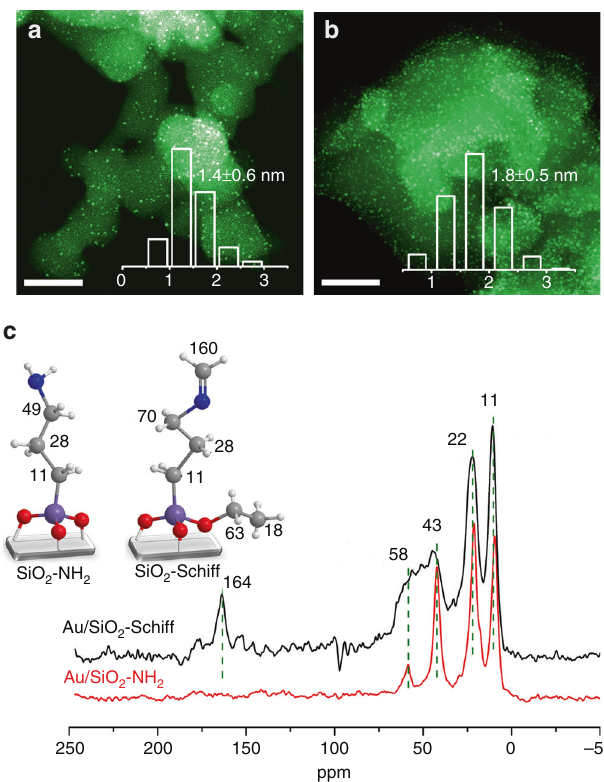
Fig. 1 Structural characterization of the two different functionalized gold catalysts. HAADF-STEM images of the prepared Au/SiO 2 -Schiff a and Au/SiO 2 -NH 2 b catalysts. Scale bar, 50 nm. 13 C CP-MAS NMR spectra of Au/SiO 2 -Schiff and Au/SiO 2 -NH 2 c . The insert shows the results of the quantum mechanics calculation of the NMR loading of ~1.5 wt%, which was determined by inductively